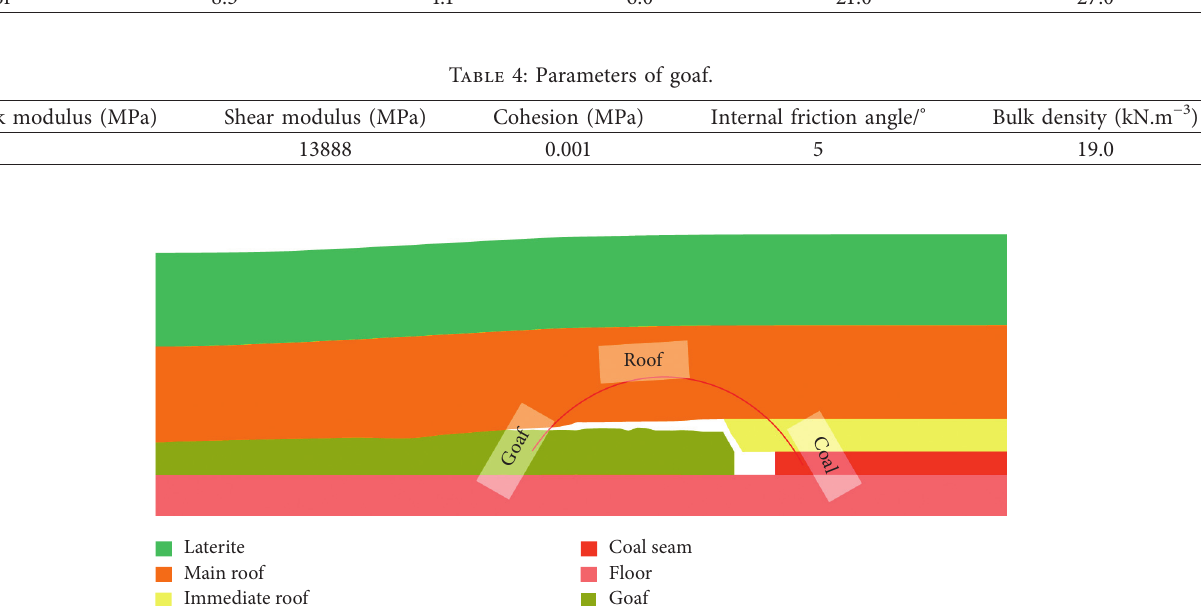
Figure 7: The GRC structure in simulation.